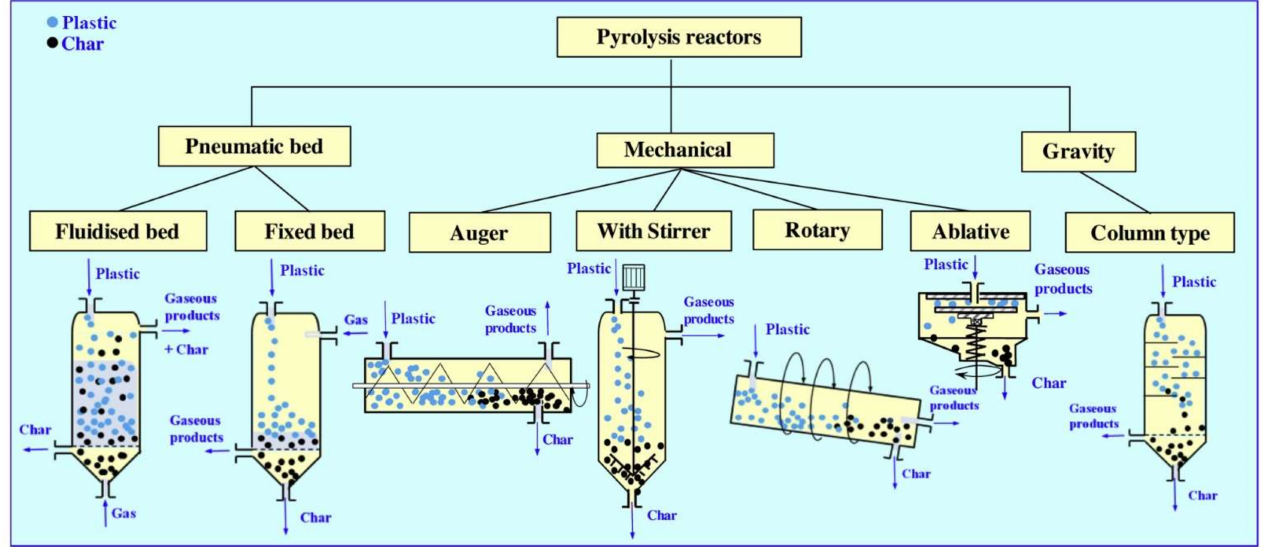
Figure 3. Different types of pyrolysis reactors. Reproduced with copyright permission from [67]